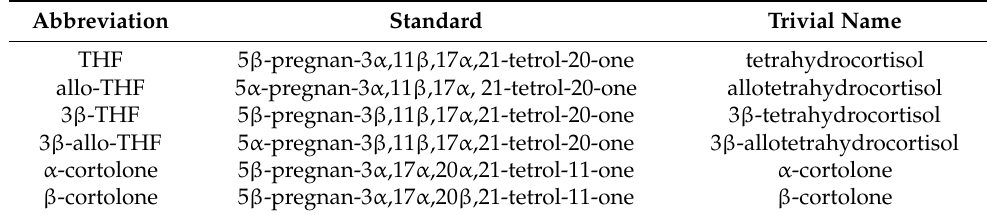
Table 2. Details of the standards of potential cortisol